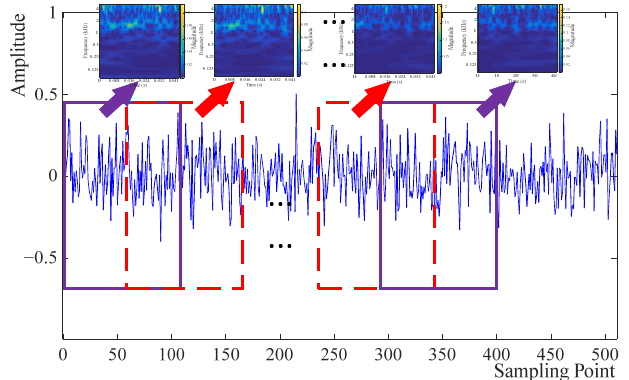
Figure 1. Schematic for generating RGB time ‐ frequency diagrams.